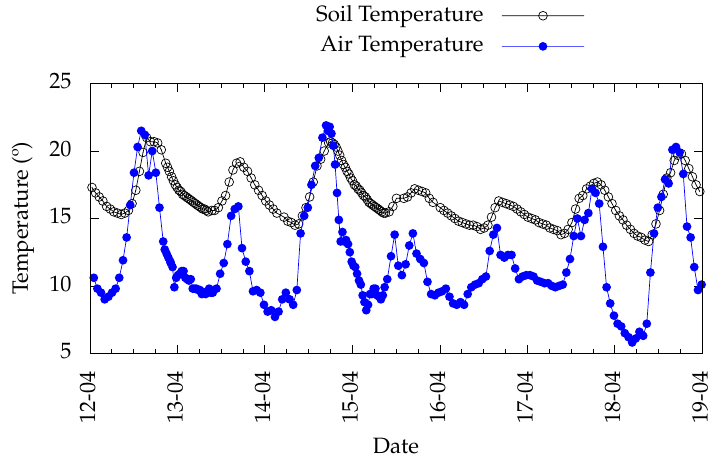
Figure 11. Temperature data from 5TE (soil) and ATMOS22 (air).